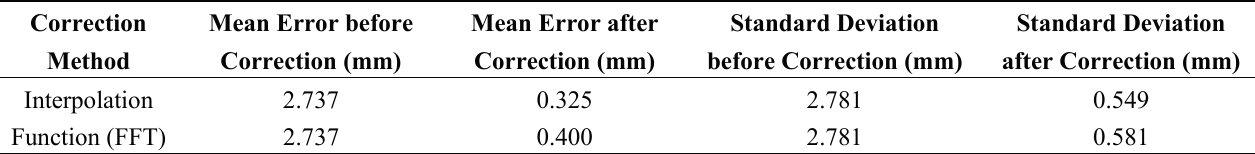
Table 16. Effectiveness of the corrections application–Topcon GPT-7501,